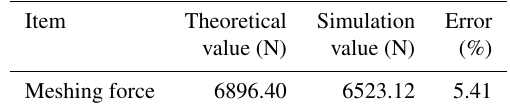
Table 2. Comparison between simulated and theoretical